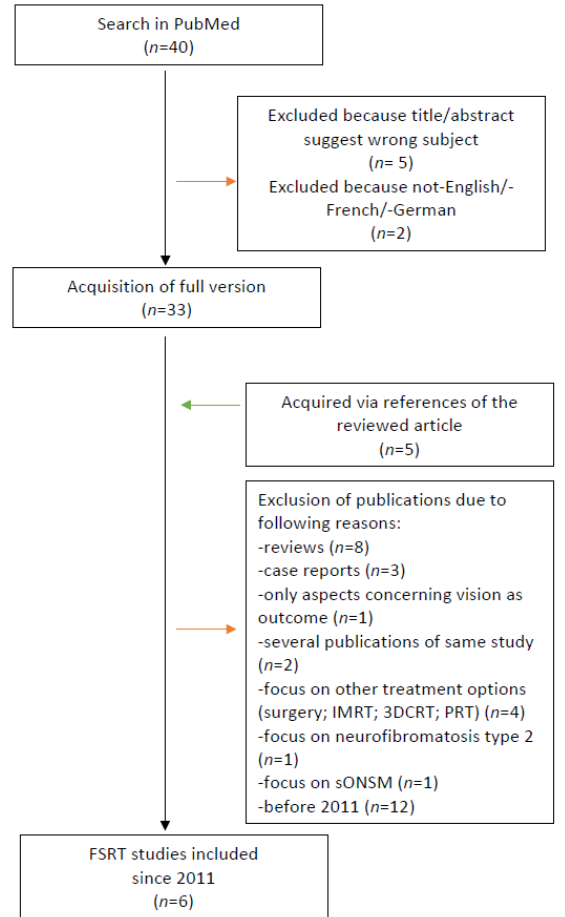
Figure 1. Selection process of studies for fractionated stereotactic radiotherapy (FSRT).